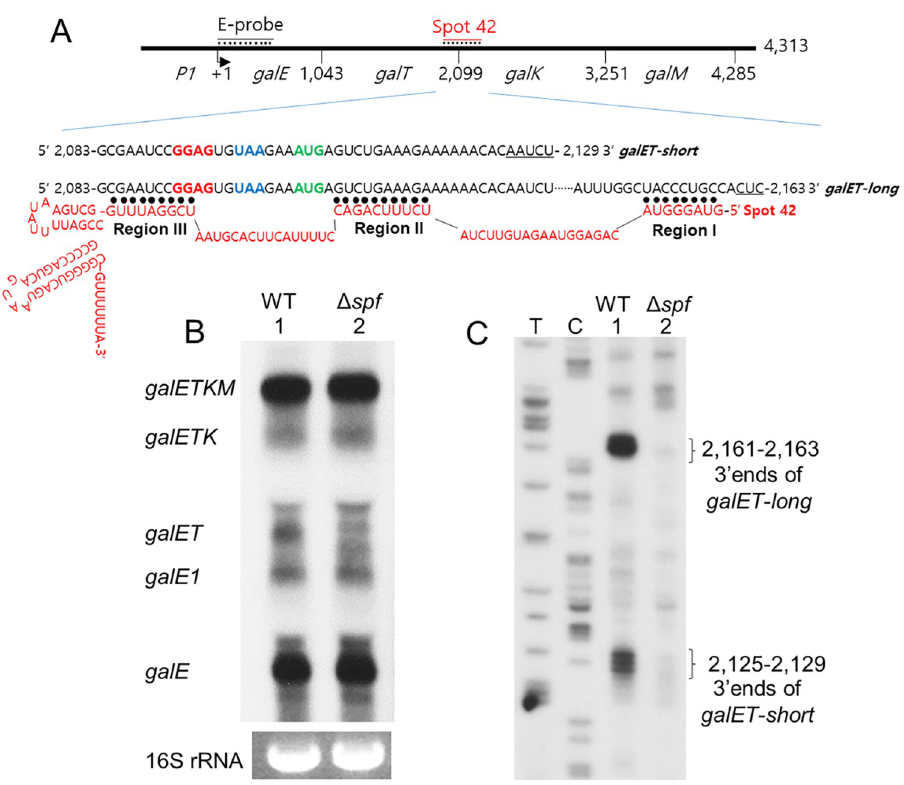
Fig 1. Spot 42 promotes generation of galET mRNA form galETKM operon. A) Schematics of the galETKM operon showing the position of the last nucleotide of the stop codon of each gene from the transcription initiation site of the P1 promoter (+1) (top line). The Spot 42 (red) binding site spans about 75 nucleotides and is located at the galT-galK junction [20]. The region of galE used to probe northern blots is marked as E-probe. The next two lines show the nucleotide sequence of the 3’ ends of galET-short and galET-long mRNA. The letters in bold are a putative Shine- Dalgarno sequence (GGAG, red letters) for galK , the stop codon (UAA, blue letters) of galT , and the initiator codon (AUG, green letters) of galK . The sequence of the entire Spot 42 RNA is shown in red and its regions that are complementary to gal mRNA are indicated by black dots and are marked as Region I, II and III. B) Northern blot with the E probe of gal mRNA from MG1655 (WT, lane 1) and MG1655 Δ spf ( Δ spf , lane 2) cells. Note that the galET mRNA band is missing in lane 2. The identity of the two faint bands in MG1655 Δ spf cells where the galET band resides has not been determined. Shown at the bottom is 16S rRNA, which was used as a loading control. C) 3’ RACE assay of 3’ ends of galET mRNA from MG1655 (lane 1) and MG1655 Δ spf (lane 2) cells. DNA sequencing ladders that serve as length markers are in lanes marked T and C. The data presented in these blots are representative of three independent experiments.